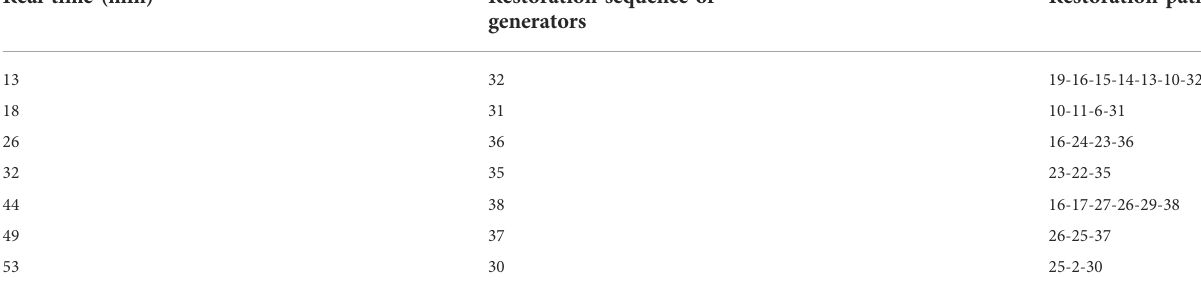
TABLE 3 The restoration scheme.